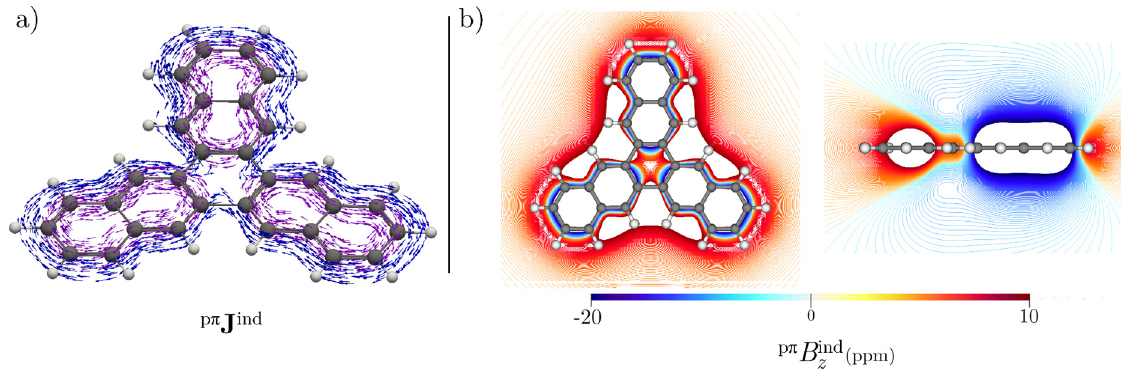
Figure 4. ( a ) p π J ind vector maps showing the diatropic peripheral ring current (in blue) and the naphthalene-like ring currents (in purple) of [7]starphene. ( b ) Isolines of p π B ind z calculated in the transverse plane (left) and the molecular plane (right) of [7]starphene (scale conventions as in Figure 2).